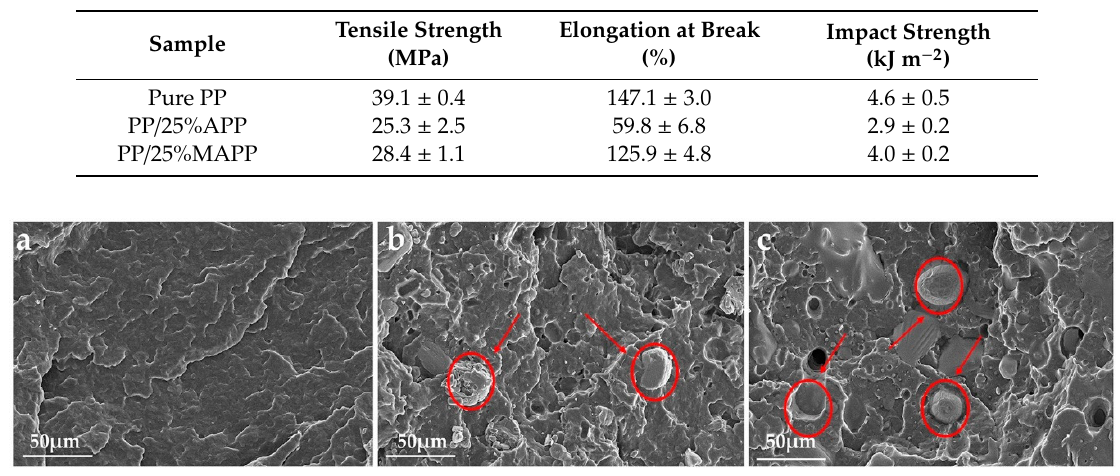
Figure 14. SEM images of the impact fractured surface of pure PP ( a ), PP/25%APP ( b ), and PP/25%MAPP ( c ).